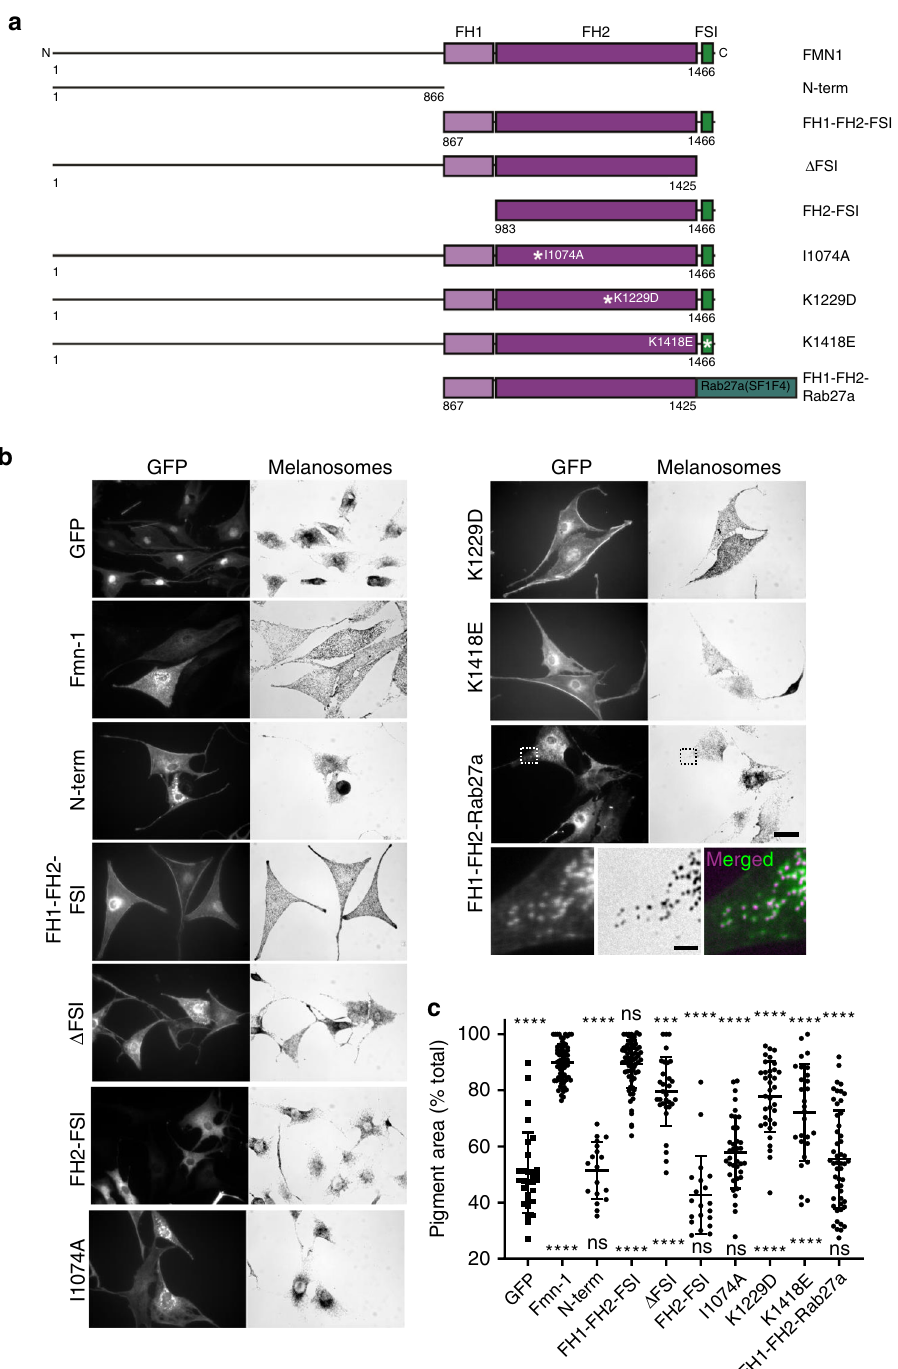
Fig. 5 The AF assembly (FH1-FH2) and SPIRE interaction (FSI) domains of FMN1 are essential for melanosome dispersion. a A schematic representation of the domain structure of murine FMN1 and the composition of truncation mutants, and chimeric proteins used in functional studies ( b , c ). White asterisks indicates the site of point mutations. Numbers indicate amino acid boundaries. b melan-f cells were plated on glass coverslips and infected with adenoviruses expressing the indicated proteins. Cells were fi xed 24 h later, processed for immuno fl uorescence and the intracellular distribution of expressed protein and melanosomes (bright- fi eld) was observed using a fl uorescence microscope (see Experimental procedures). Scale bars = 20 μ m and 2 μ m for magni fi ed region. Dashed boxes in FH1-FH2-Rab27a images indicate the region of the image shown in high magni fi cation below. The merged image show melanosomes and FH1-FH2-Rab27a coloured magenta and green. c A bee swarm plot showing the extent of pigment dispersion in cells expressing the indicated proteins. n = 30 (GFP), 59 (FMN1), 18 (N-term), 70 (FH1-FH2-FSI), 31 ( Δ FSI), 20 (FH2-FSI), 37 (I1074A), 35 (K1229D), 28 (K1418E) and 51 (FH1-FH2-Rab27a). ****, **, * and n.s. indicate signi fi cant differences of p = <0.0001, 0.01, 0.05 and no signi fi cant difference as determined by one-way ANOVA. Signi fi cance indicators above and below each dataset indicate differences between that dataset and the positive (FMN1 wild type) and negative (GFP alone) controls. Results shown are representative of three independent experiments. Bars indicate the mean and 25th and 75th percentile of data. FH formin homology, FSI formin-SPIRE interaction sequence. Source data for c are provided in the Supplementary Source data fi